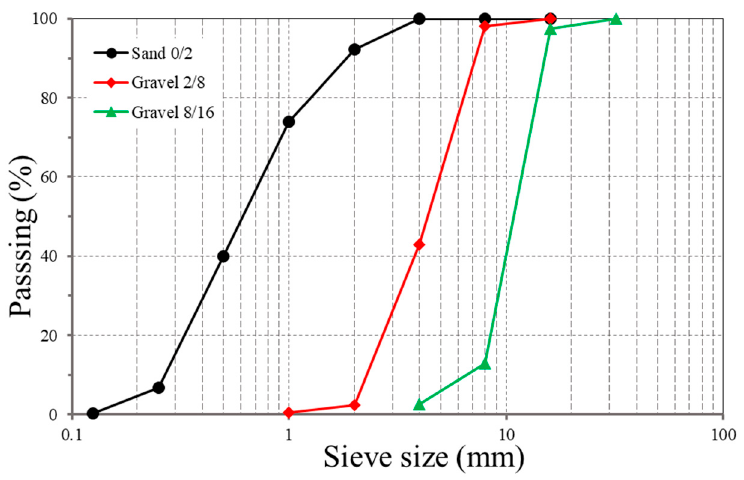
Figure 1. Aggregate grading curves.